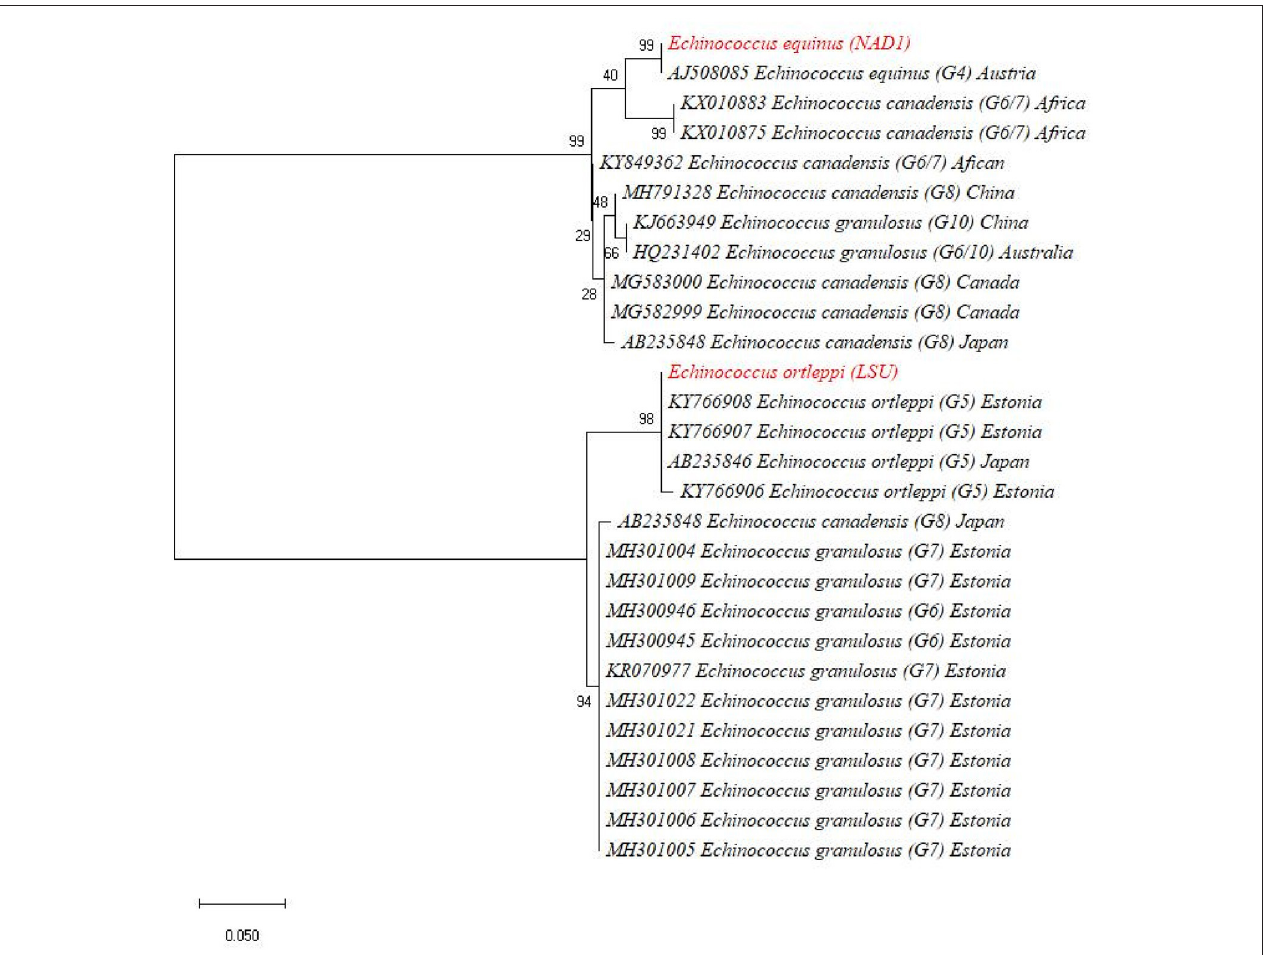
FIGURE 4 | Maximum likelihood phylogenetic tree showing Echinococcus ortleppi (G-5) and Echinococcus equinus (G4) from Khyber Pakhtunkhwa, Pakistan, based on nucleotide sequences of the LSU (rrnl) and NAD1 genes.